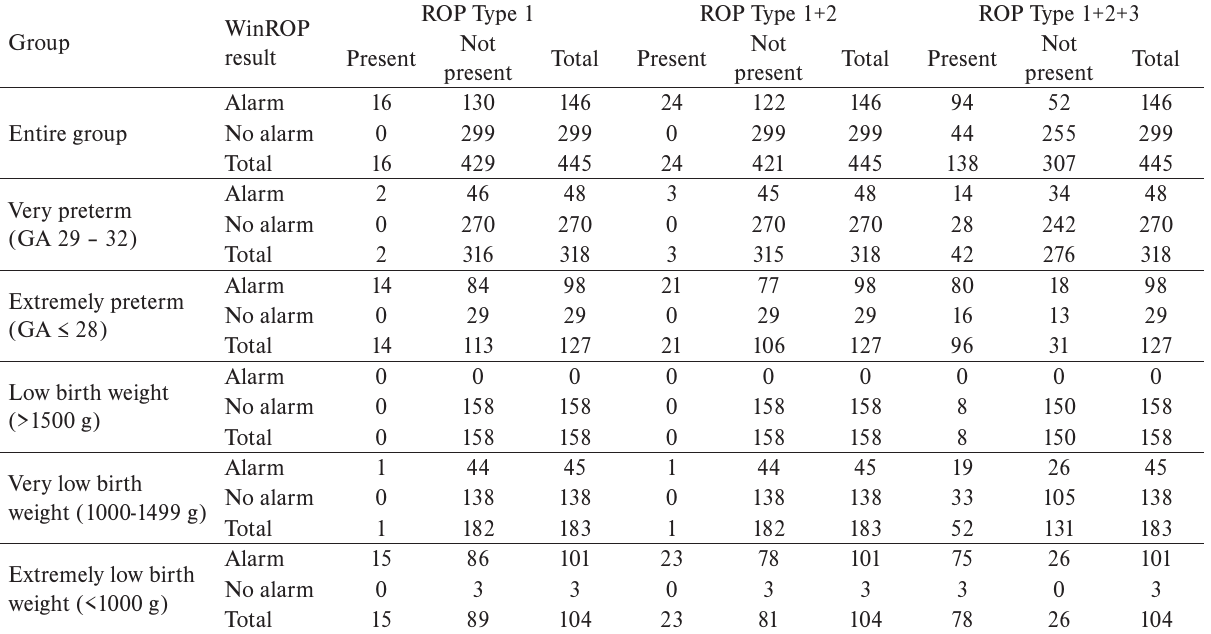
Table 1. Results of WinROP alarm compared to diagnosis established by standard means.